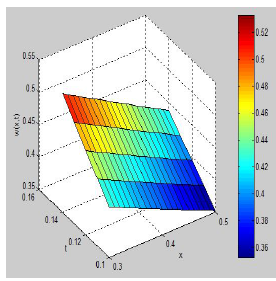
Fig. 2: Surface graph of w ( x , t ) of eq. (8.1), when α =